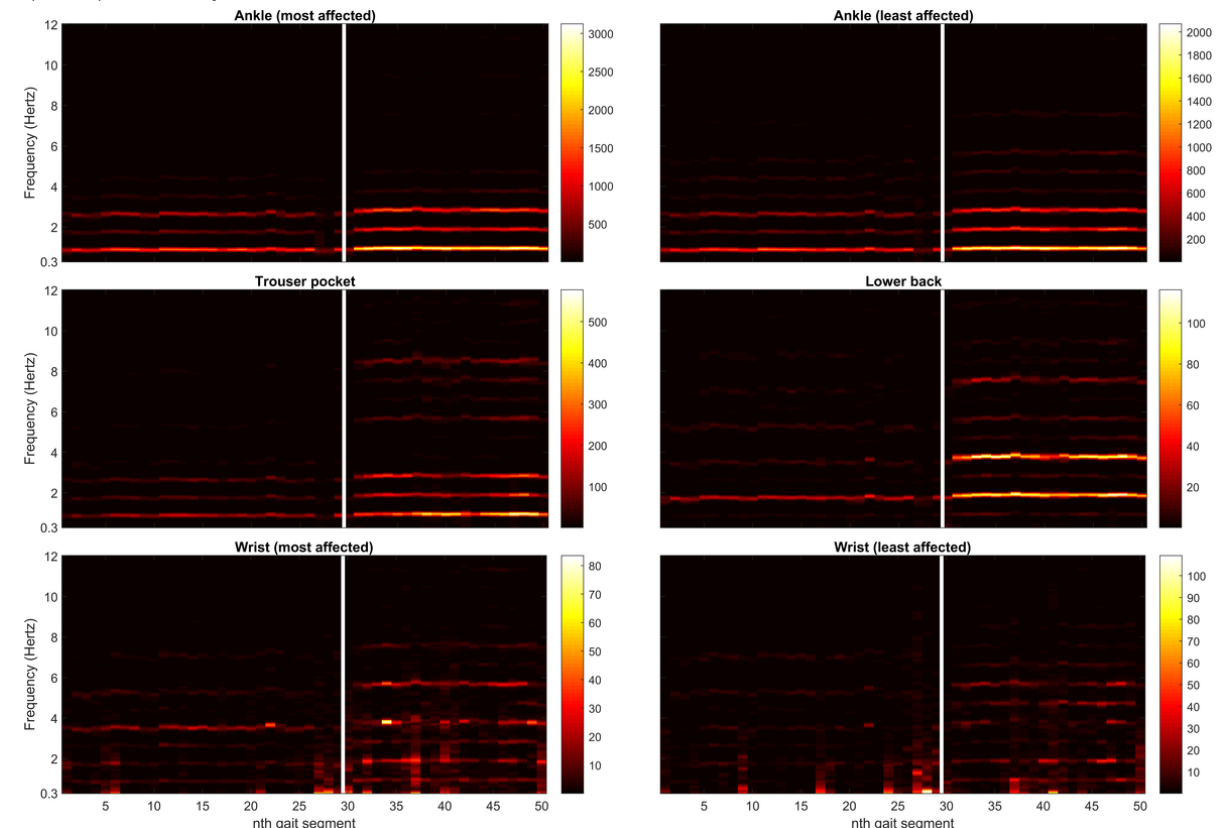
Figure 2. Visualization of the PSD of one of the patients who shows a clear response after medication intake (PD_14). x-axis: nth gait segment of 25 seconds (the white line indicates intake of dopaminergic medication). y-axis: frequency (Hertz). Color bar: PSD in (m/s 2 ) 2 /Hz. PD: Parkinson disease; PSD: power spectral